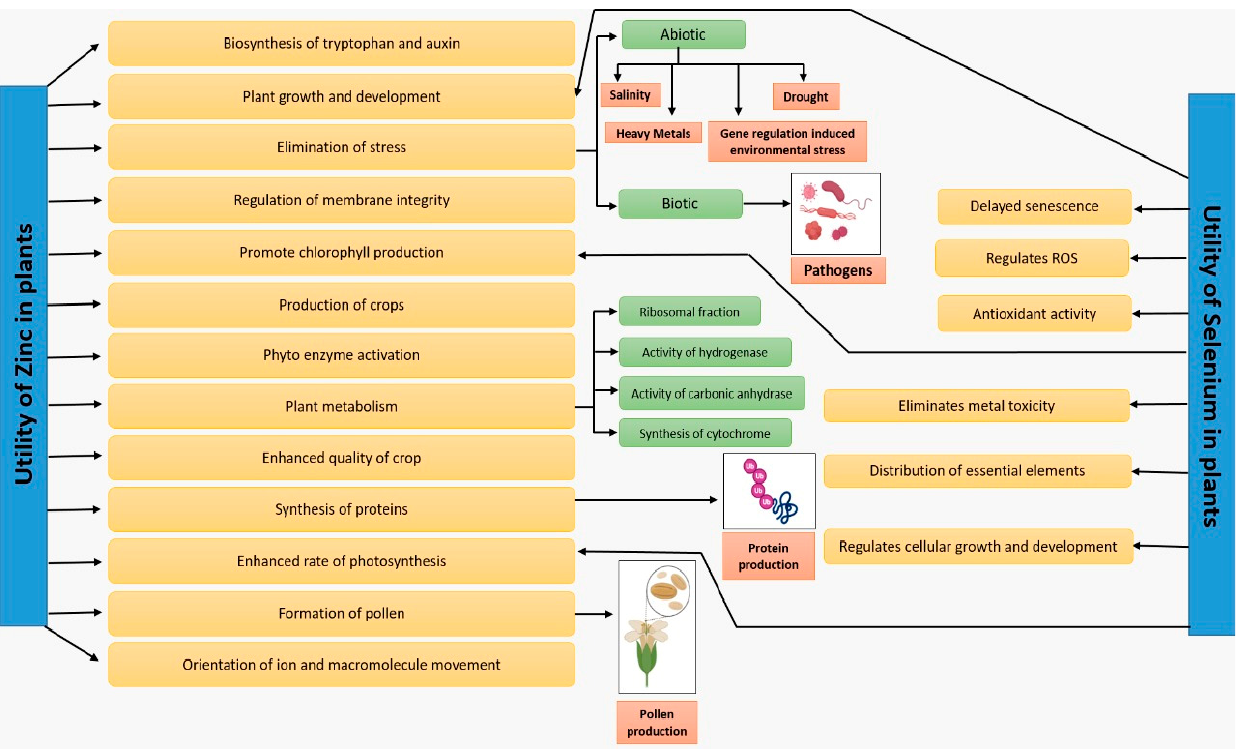
Figure 2. Positive effects of zinc and selenium in